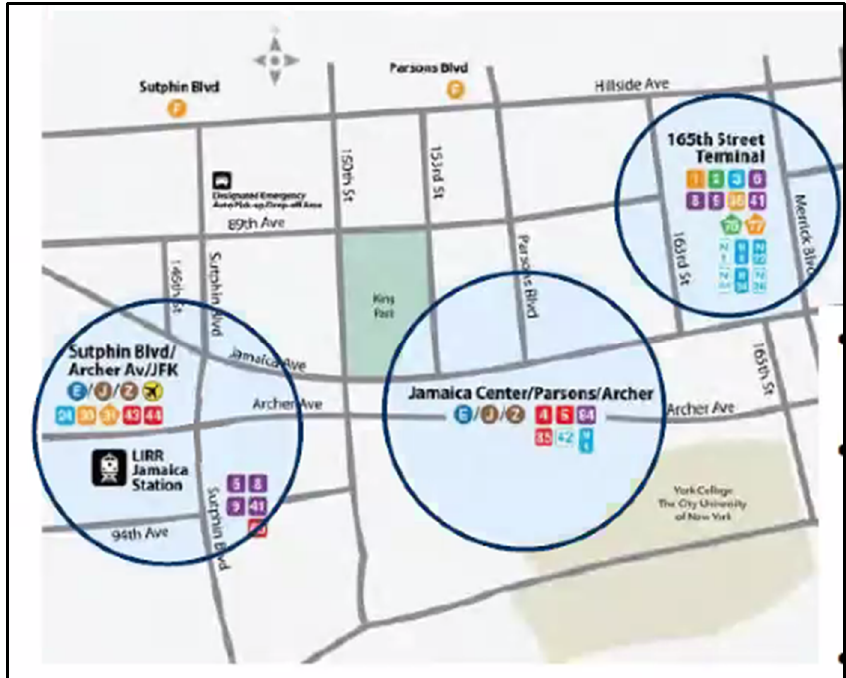
Figure 1. Jamaica Center-Parsons-Archer transportation hub. Table 1. Description of Sample